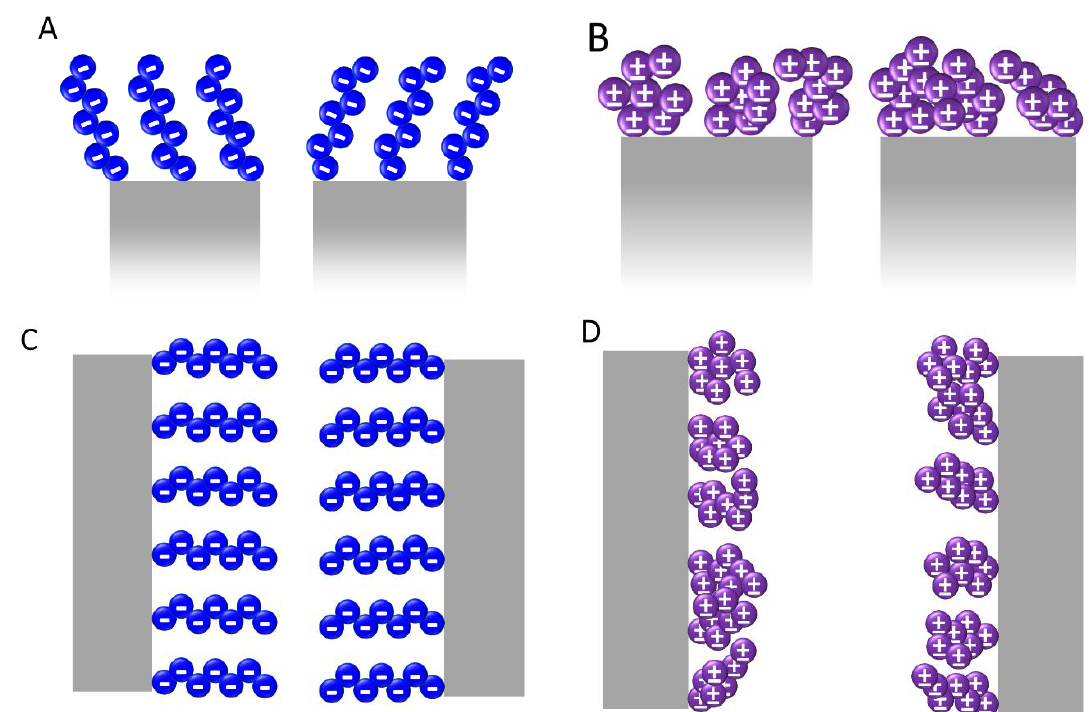
Figure 3. Effect of extended and collapsed polyelectrolyte chains on the membrane surface: ( A ) extended chains on the top or bottom surface; ( B ) collapsed chains on the top or bottom surface; ( C ) extended chains on the inner pore walls; and ( D ) collapsed chains on the inner pore walls. Chain collapse can occur as a result of the protonation of the repetition unit or the complexation of multivalent ions such as Cu 2+ by the repetition units.